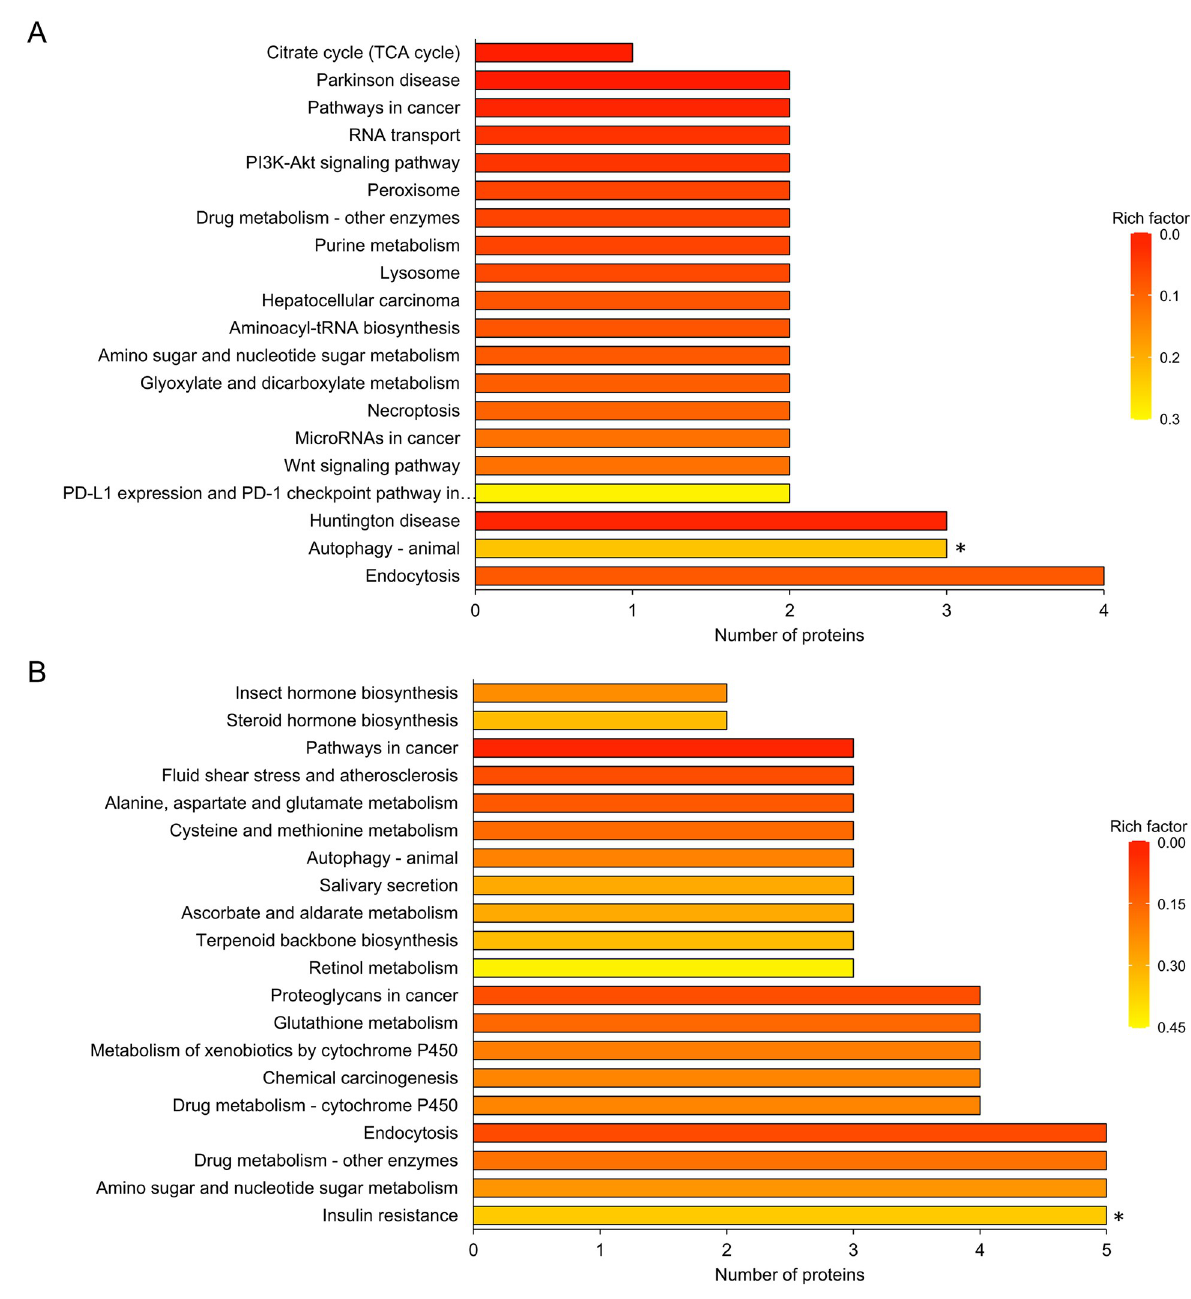
Fig 6. Kyoto Encyclopedia of Genes and Genomes (KEGG) enrichment analysis of differentially abundant proteins (DAPs) between non- diapause-(ND) and diapause-destined (D) pupae of Bactrocera minax . (A) KEGG enrichment in ND1 vs D1 comparison. (B) KEGG enrichment in ND15 vs D15 comparison. The color gradient corresponds to the magnitude of rich factor, which reflects the ratio of number of DAPs and all proteins that were assigned to the same pathway. Top 20 KEGG pathways in each comparison are shown. Asterisks indicate the significance of difference ( p <